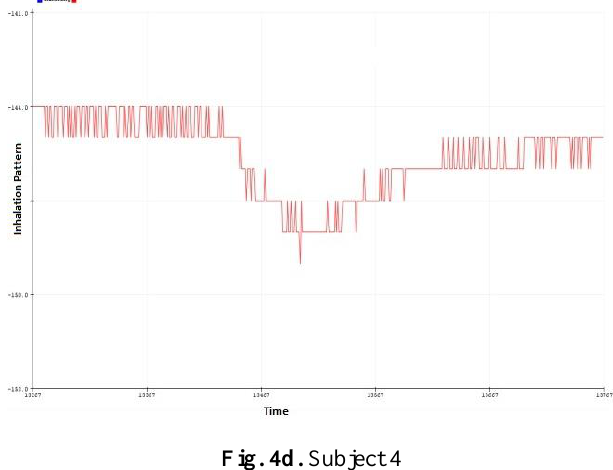
Fig. 4. Variation in breath or inhalation level of a normal person with respect to time, which ranges from -142 liters